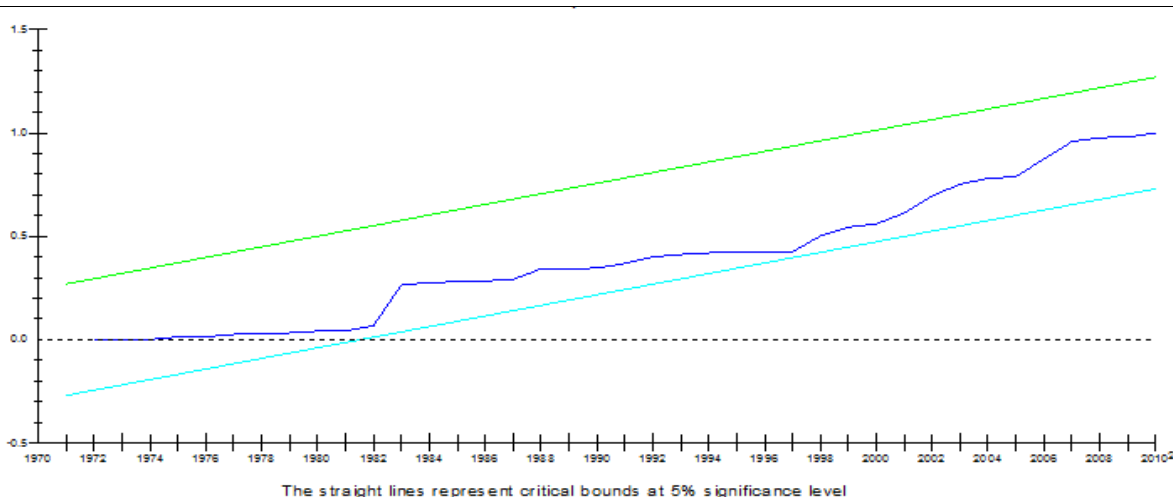
Fig. A2. Plot of Cumulative Sum of Squares of Recursive Residuals (CUSUMSQ)